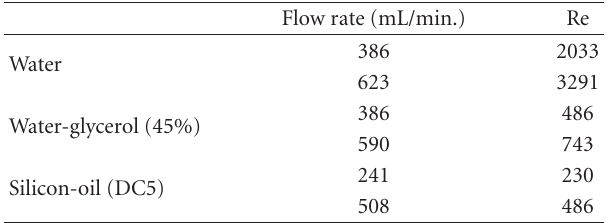
Table 3: Details of the flow rate and Reynolds number presented in this work.